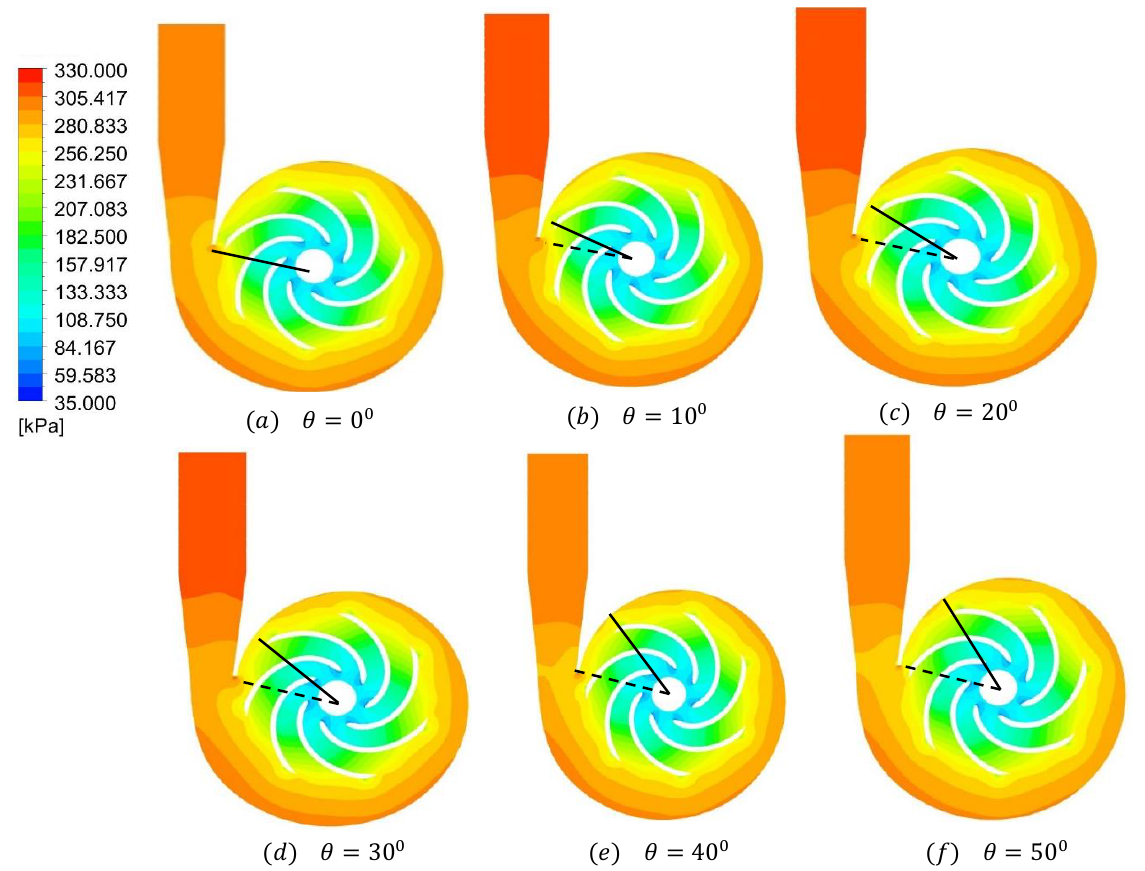
Machines 2021 , 9 , 60 Figure 14. Pressure contours plotted on the turbo surface at 50% of the span corresponding to various phase angles.